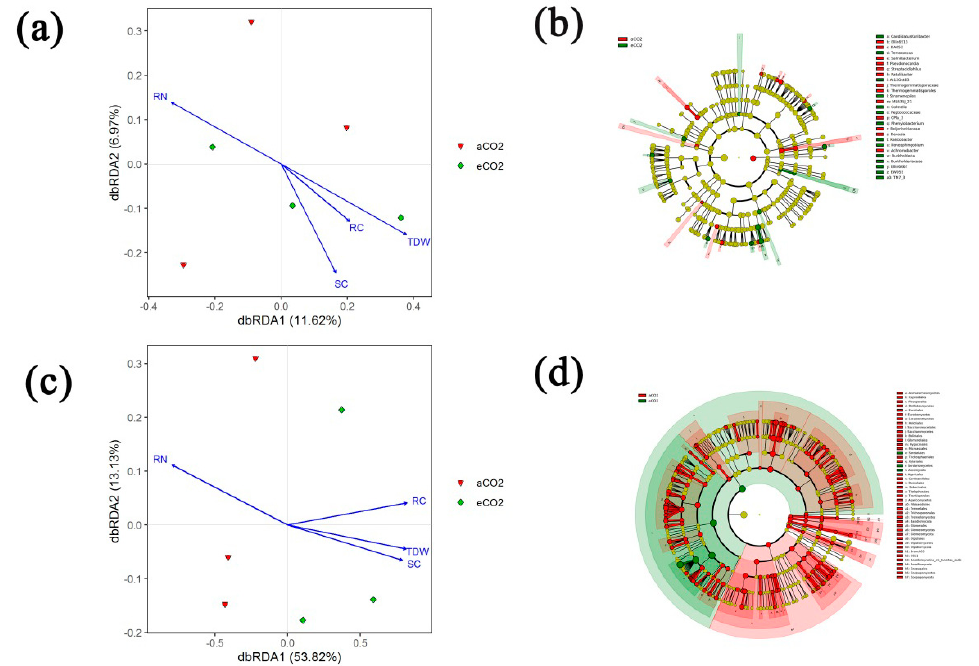
Figure 3. Distance-based redundancy analysis (dbRDA) and Linear discriminant analysis E ff ect Size (LEfSe) analysis of the relative abundance of bacterial community ( a , b ) and fungal community ( c , d ). In detail, ( a ) dbRDA of bacterial community with plant characteristics as explanatory variables under aCO 2 and eCO 2 . Only the first axis was significant with an explained variation of 11.62% ( p = 0.0389) and the permutation value of the overall model was 0.0486. ( b ) LEfSe analysis of the relative abundance of bacteria between aCO 2 and eCO 2 treated soil samples. A total of 28 biomarkers were observed from the level of kingdom to genus. Labels exhibited in the figure were ranged from the level of phylum to genus. p < 0.05. ( c ) dbRDA of fungal community with plant characteristics as explanatory variables under aCO 2 and eCO 2 . Only the first axis was significant with an explained variation of 53.82% ( p = 0.0167), RC alone explained 17.5% of the total variance and the permutation value of the overall model was 0.0153. ( d ) LEfSe analysis of the relative abundance of fungi between aCO 2 and eCO 2 treated soil samples. A total of 167 biomarkers were observed from the level of kingdom to genus. Labels exhibited in the figure were ranged from the level of phylum to order although significant changes were also occurred at the level of genus. p < 0.05.